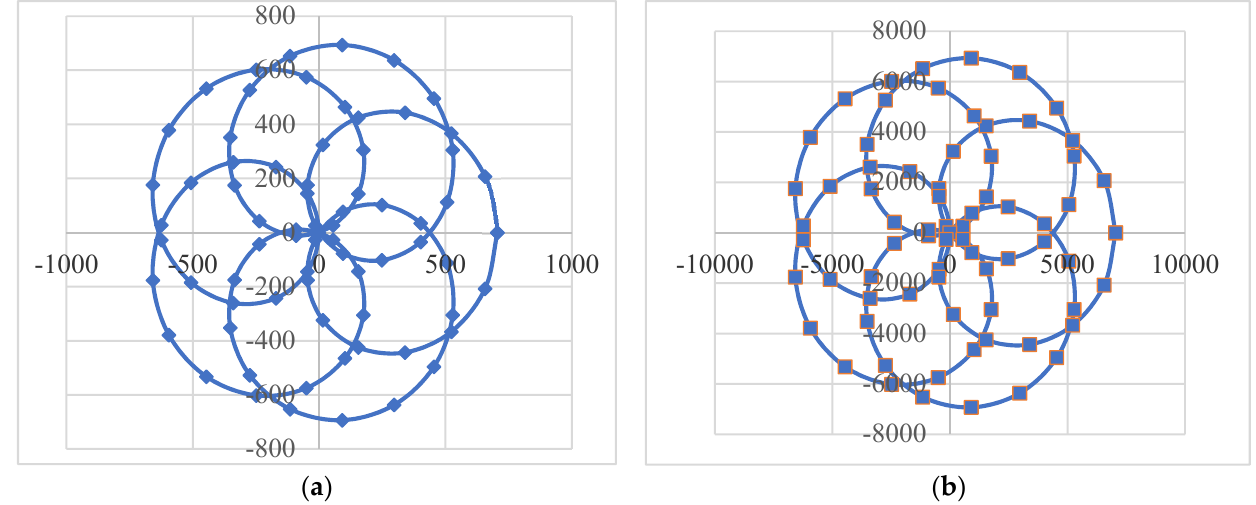
Figure 7. Scan patterns produced by the configuration ba-ab of Risley prisms (Figure 2d), for k = 1, M = 6, and ( a ) L = 10 m; ( b ) L = 100 m. The values on the axes are in millimeters.